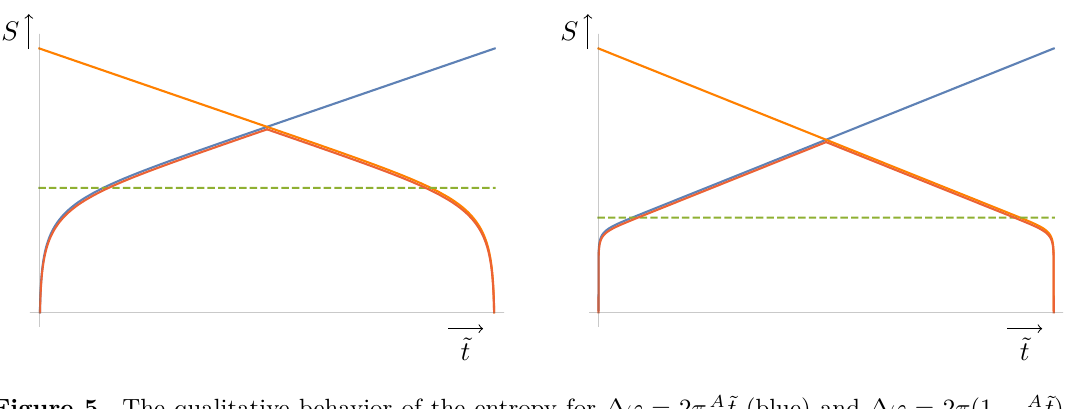
Figure 5. The qualitative behavior of the entropy for ∆ ϕ = 2 π A (orange) shows that it follows the Page curve (red line). To plot we set ‘ = G = 1 , r ∞ = 10 100 . 000 , the evaporation rate A = 5 and R = 2 ‘ on the left, R = 10 ‘ on the right. The dashed green line indicates the UV